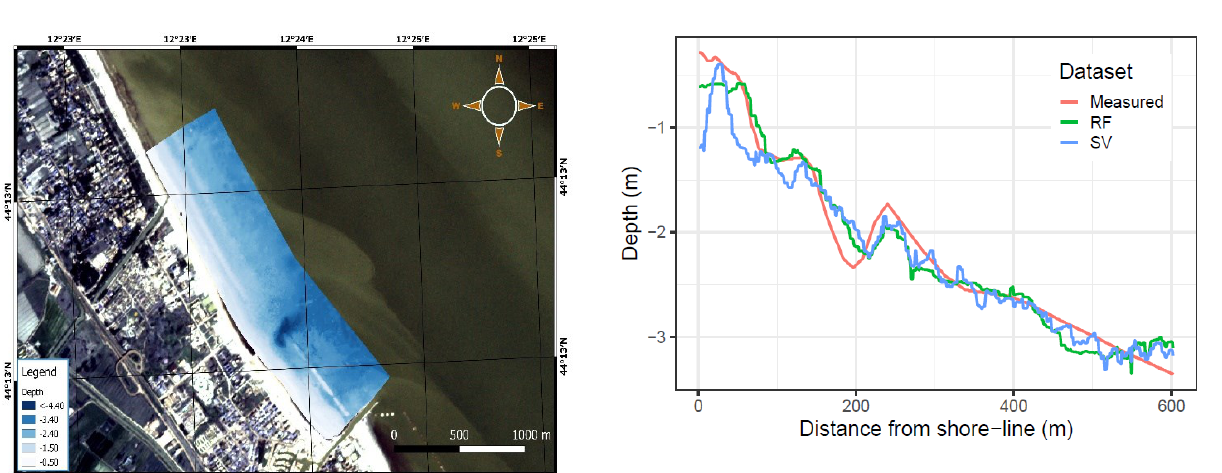
Figure 9. Depth values of three of the transects used for